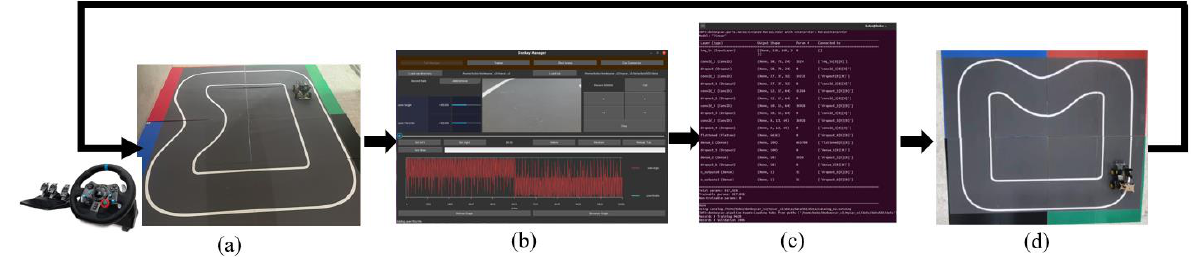
Figure 4. Flow of the autonomous vehicle training and verification process, ( a ) driving for data collection, ( b ) data correction, ( c ) training through the neural network, and ( d ) testing and scoring.